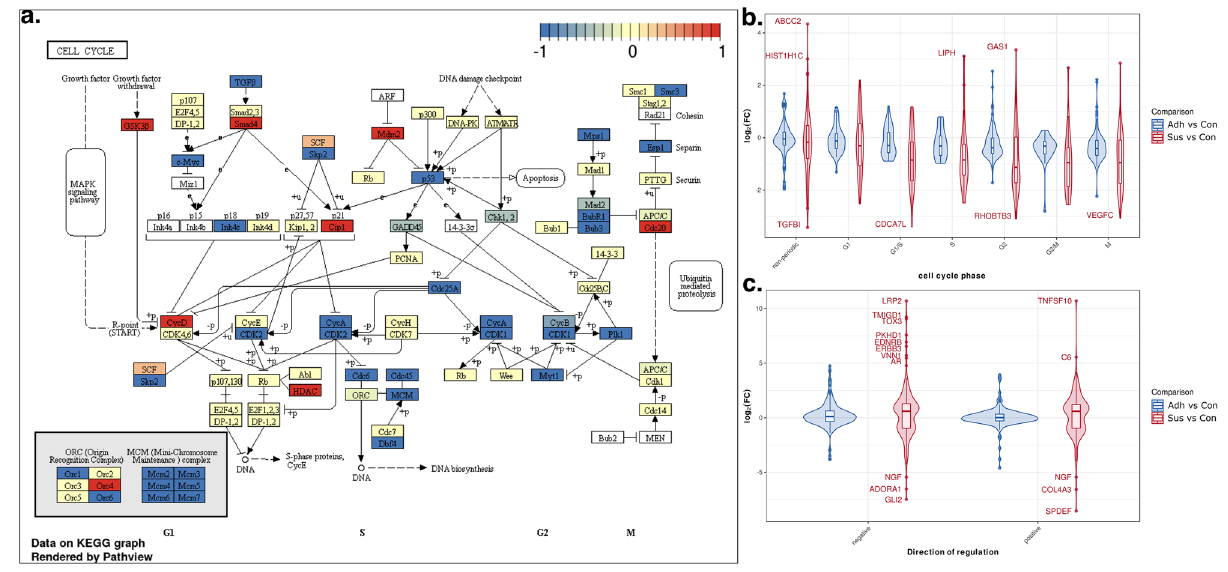
Figure 5. Expression regulation of cell cycle related genes. ( a ) KEGG cell cycle showing differentially regulated genes for the comparison of Sus_CDM2 against Adh_CDM2 rendered with Pathview. The color code determines the direction of significantly differentially regulated genes (FDR < 0.001) according to the legend at the top of the figure. A white background of a text box means that the gene was not identified as expressed. ( b ) LFC for the top 500 cell cycle related genes from Cyclebase 3.0 grouped to their peak expression phase. Non-periodic: no known expressional changes during the cell cycle, G1: Gap phase 1 of the cell cycle, G1/S: Gap 1 to synthesis transition phase, S: synthesis phase, G2: Gap phase 2, G2/M: Gap2 to mitosis transition phase, M: mitosis phase. ( c ) LFC for genes linked to positive (positive) or negative (negative) regulation of apoptosis according to gene